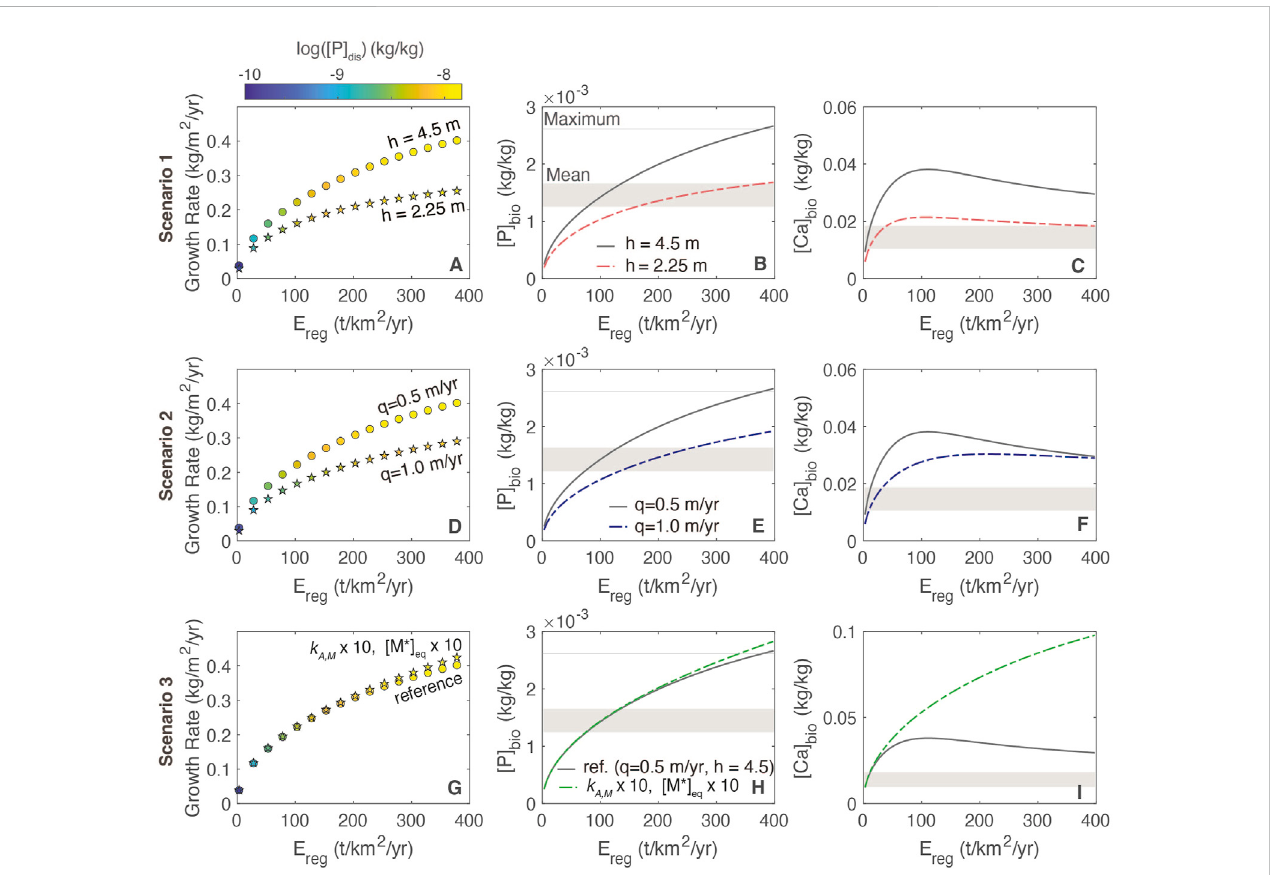
FIGURE 7 Relationships among growth rate, foliar stoichiometry and erosion rate for different plant-regolith interaction scenarios. (A – C) regolith thickness (scenario 1); (D – F) different fl ow rates (scenario 2); (G – I) increased mineral dissolution rates and increased [M*] eq (scenario 3). In panels A, D and G, circles correspond to the reference model and stars correspond to scenarios. The grey shaded bar shows the range of foliar concentrations typical of tropical deciduous forests from Kattge et al. (2011). The light grey lines in B, E and H are the maximum [P] fol levels from Wang et al.